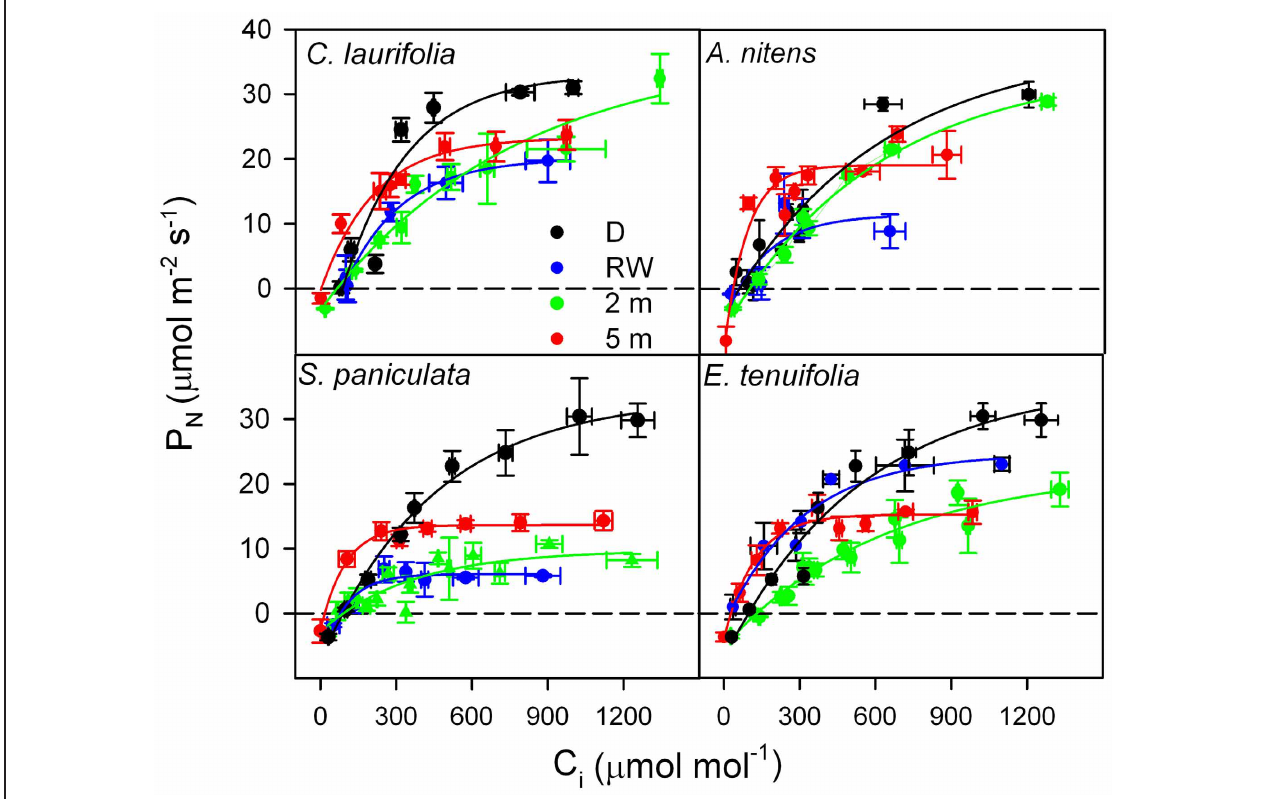
FIGURE 6 | Response curves of photosynthetic rate to intercellular [CO 2 ] in the species indicated during drainage (black), rising-waters (blue), flooding by 2-m water column (green), and full flood by 5-m water-column (red). Modified from Herrera et al. (2008a).